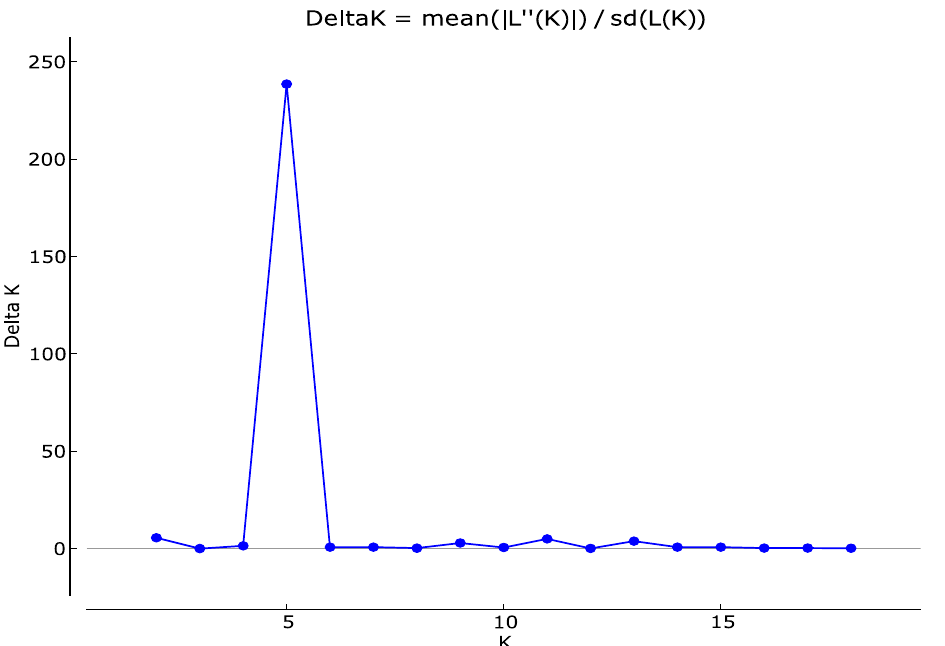
8 of 17 Figure 1. Maximum likelihood dendrogram topology ( − ln = 5698.207) depicting the genetic relationships among the different biotypes. The Vr, TvP and Ch biotype samples formed monophyletic groups. The Vr and TvP received statistical support from all tests, while the Ch clade was corroborated by the BT and SH-aLRT values (Supplementary Figure S1). The TvT samples were almost all grouped together (Figure 1). However, four of them (TvT2_15, TvT2_16, TvT2_34, TvT2_32) clustered with the Vr clade. Finally, the Cf samples formed a global cluster that